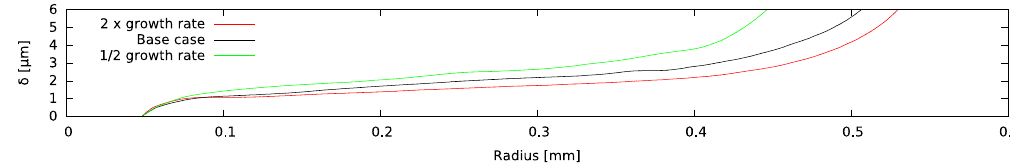
Figure 11. Effect of bubble growth rate on microlayer formation. Bubble and microlayer shapes are compared at constant bubble volume.